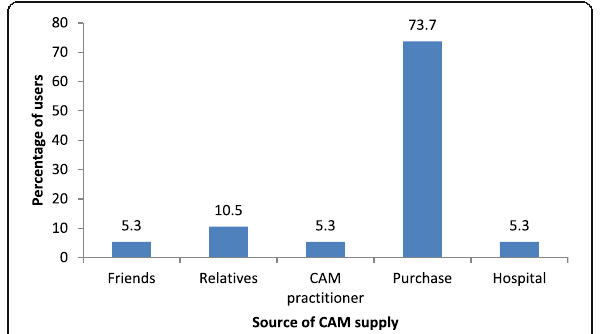
Fig. 5 Source of CAM supply. CAM, complementary and alternative